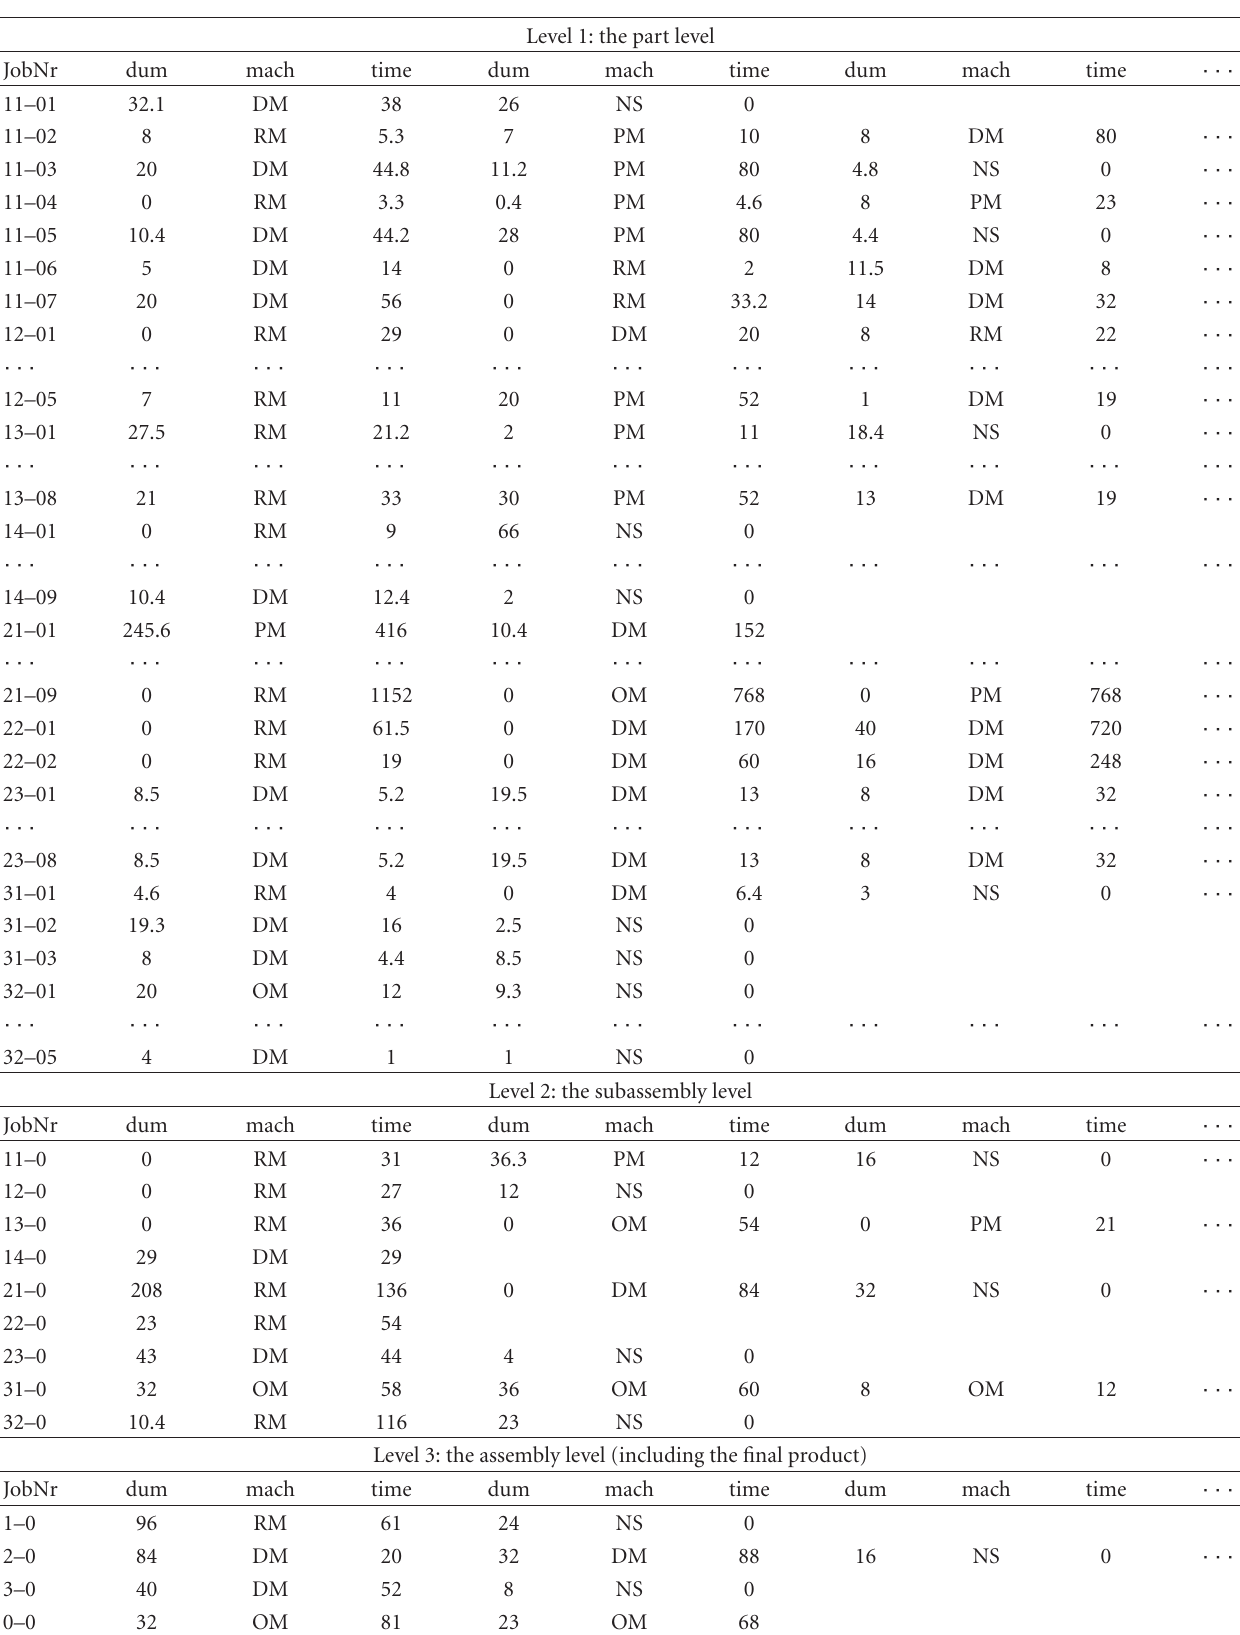
Table 2: The modified data of case study